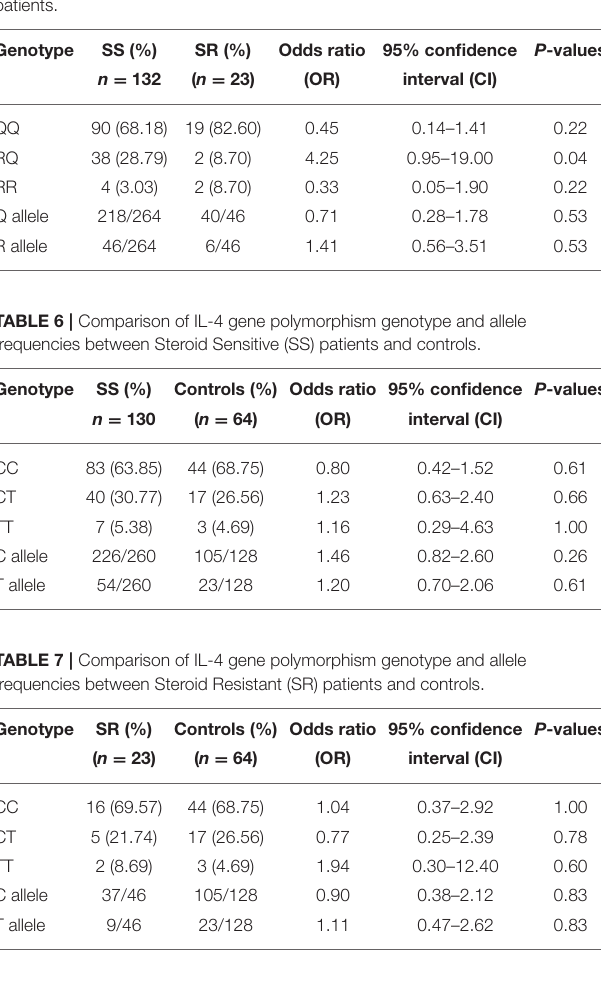
TABLE 9 | Comparison of IL-13 gene polymorphism genotype and allele frequencies between Steroid Resistant (SR) patients and